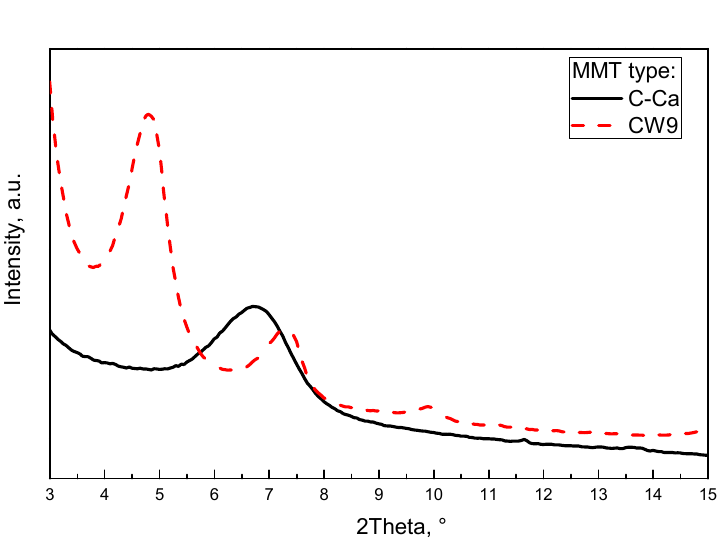
Figure 1. X-ray diffraction (XRD) patterns for powdered MMTs. Figure 1. X-ray di ff raction (XRD) patterns for powdered